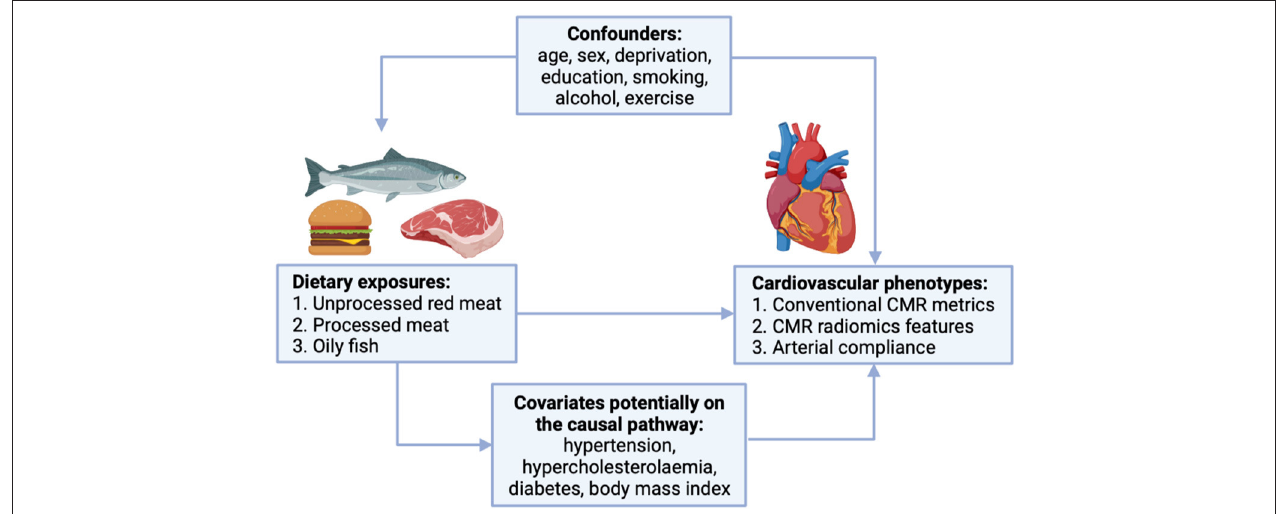
FIGURE 2 | Covariates considered in the relationship between red and processed meat consumption and cardiovascular phenotypes. CMR, cardiovascular magnetic resonance.